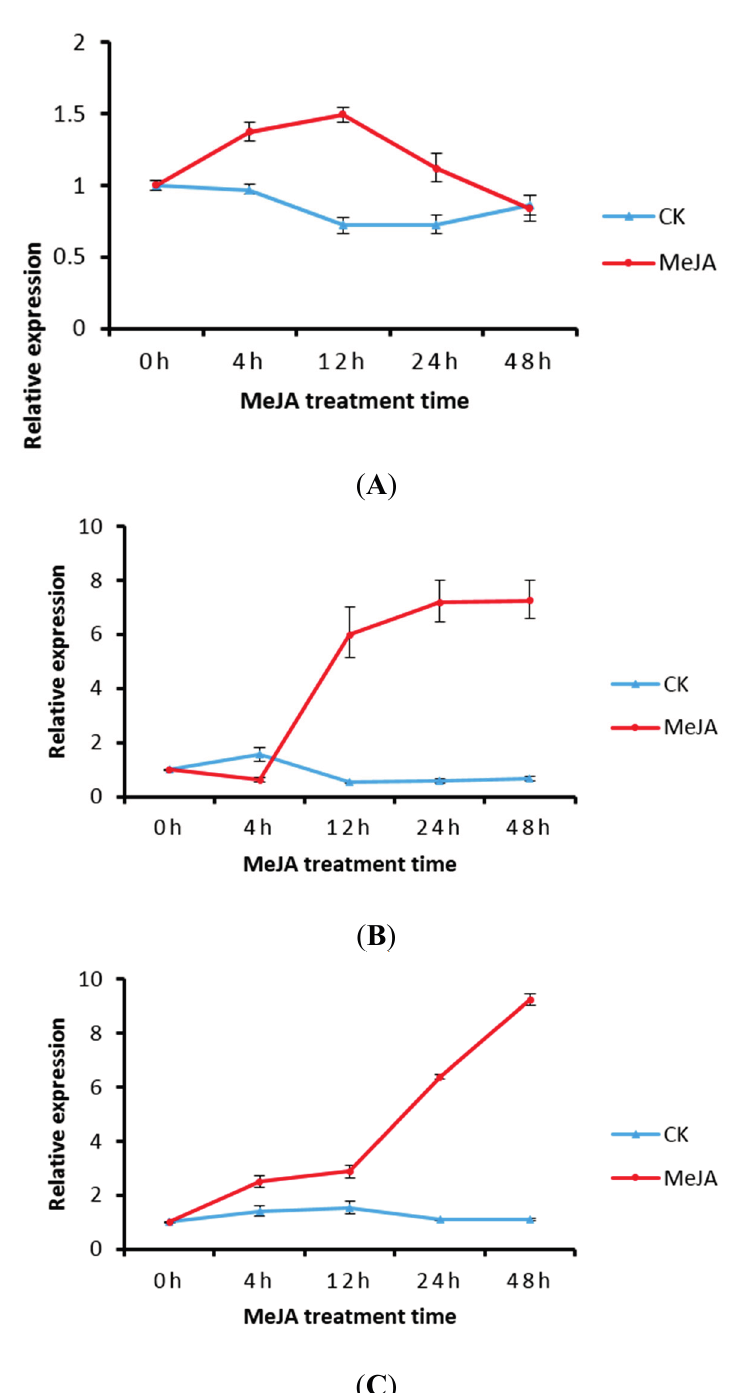
The results indicated that the upregulating expression of TwDXS2 and TwDXR enhanced the synthesis of triptophenolide in suspension cells.